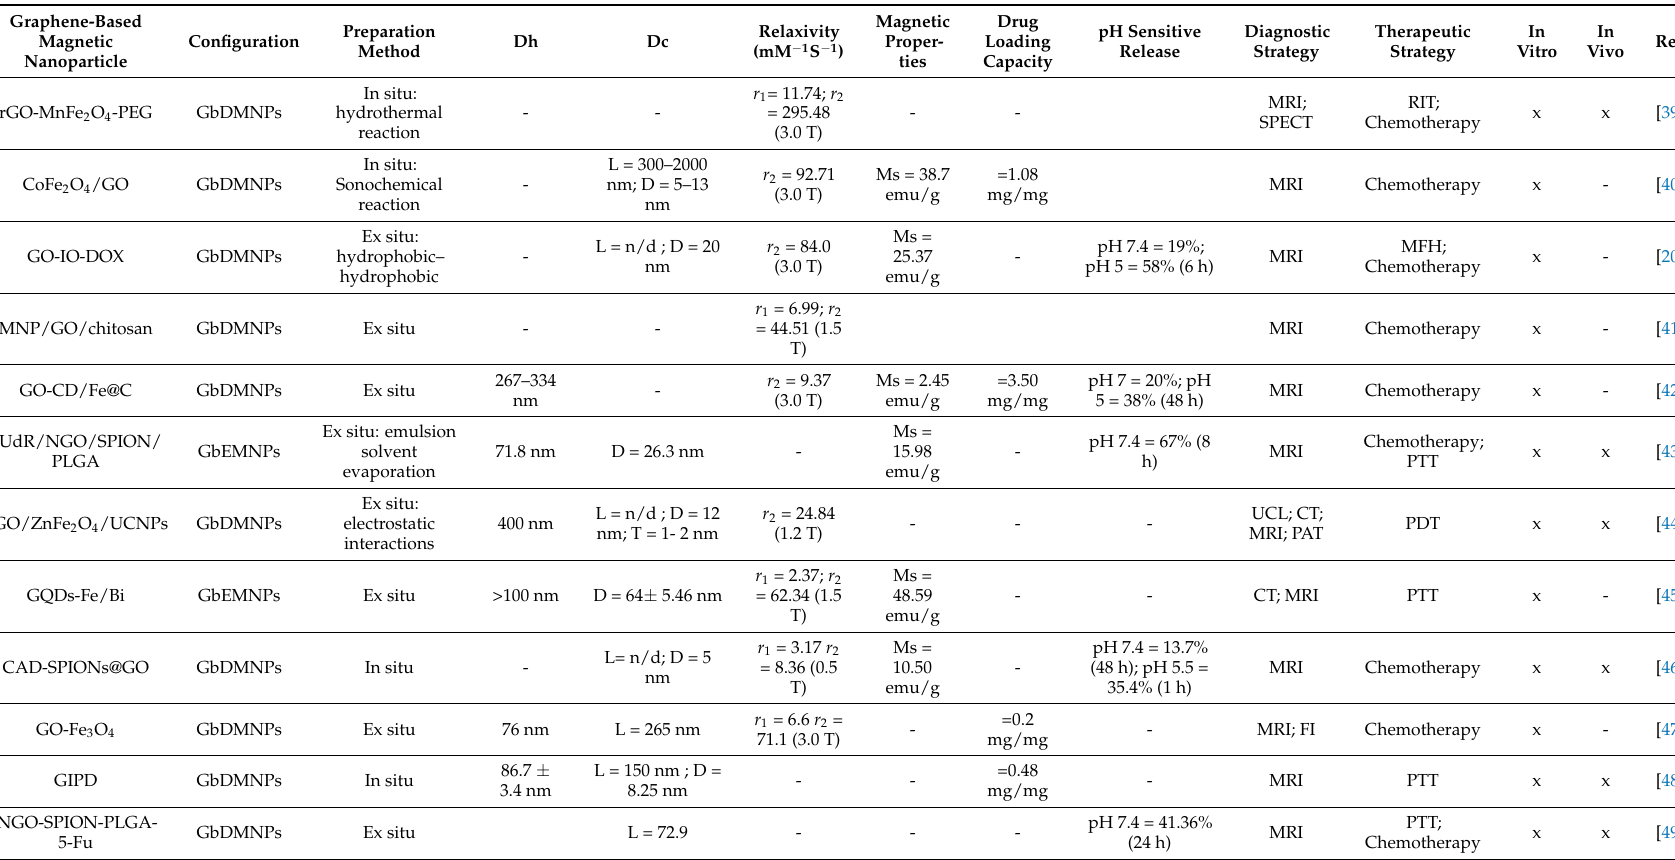
Table 1. Summary of characteristics of GbMNPs for theranostic applications, including configuration, preparation method, Dh (Diameter by DLS), Dc (Diameter by TEM), relaxivity, SAR (specific absorption rate), drug loading capacity, pH sensitive release, diagnostic strategy, therapeutic strategy, in vitro and in vivo